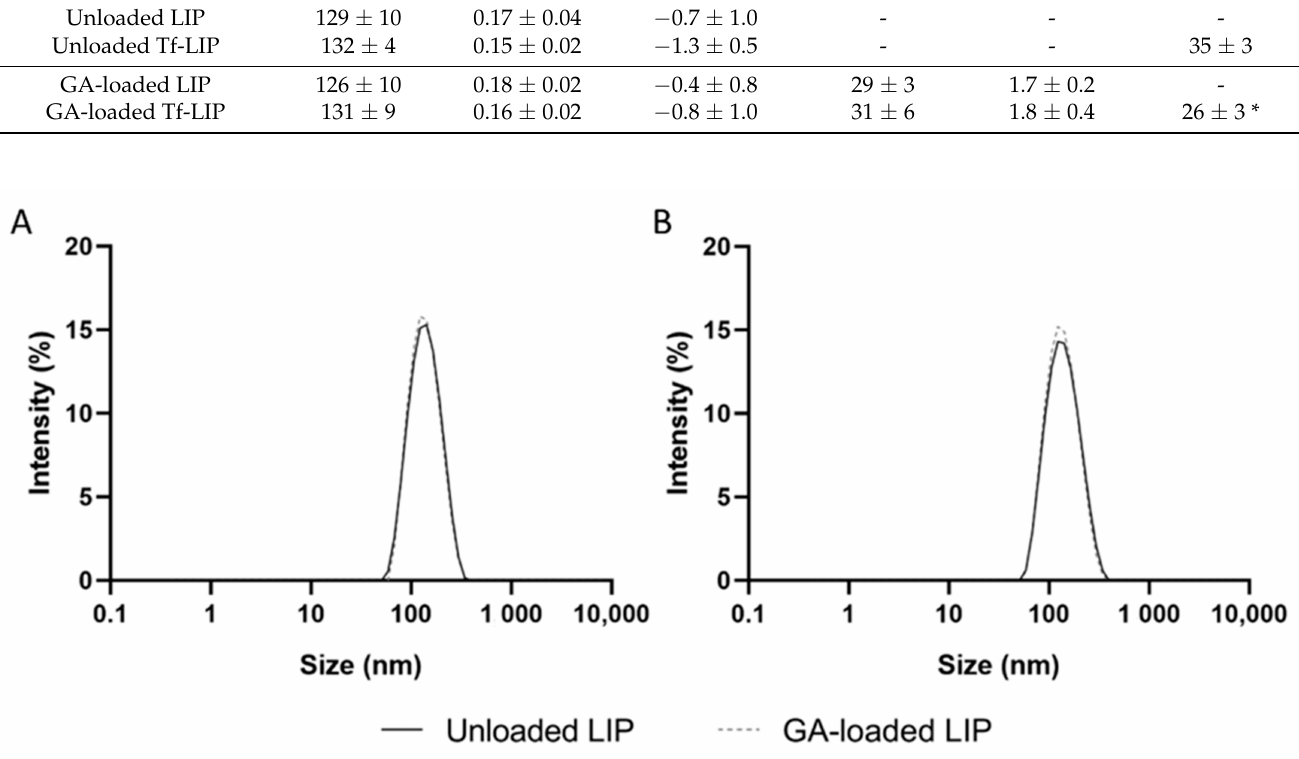
Figure 2. Size distribution by intensity of unloaded (black line) and GA-loaded liposomes (dashed gray line) ( A ) before and ( B ) after Tf